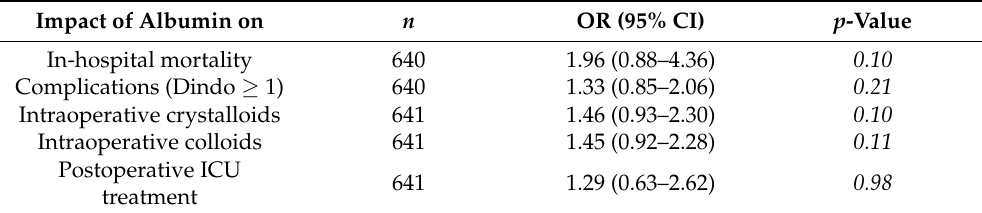
Table 4. Impact of Albumin on different outcome parameters. Results of the logistic and linear regression analysis. All regression models were adjusted for ASA grade, sex, age, CCI, type of fracture. OD, odds ratio; CI, confidence interval; ICU, intensive care unit. Impact of Albumin on n